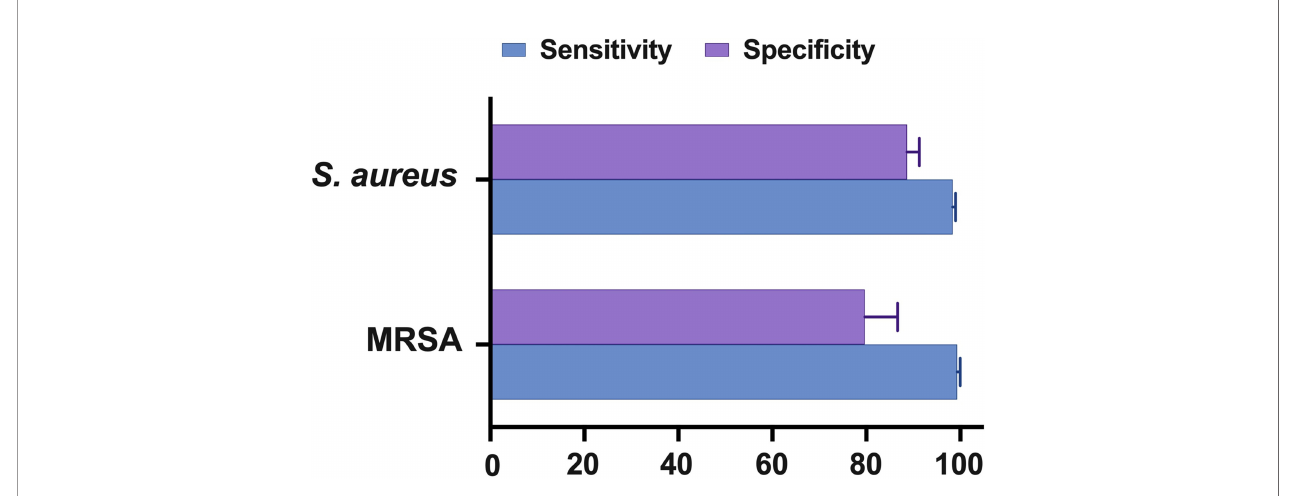
FIGURE 5 | Summary of NAAT ’ s pooled sensitivity and speci fi